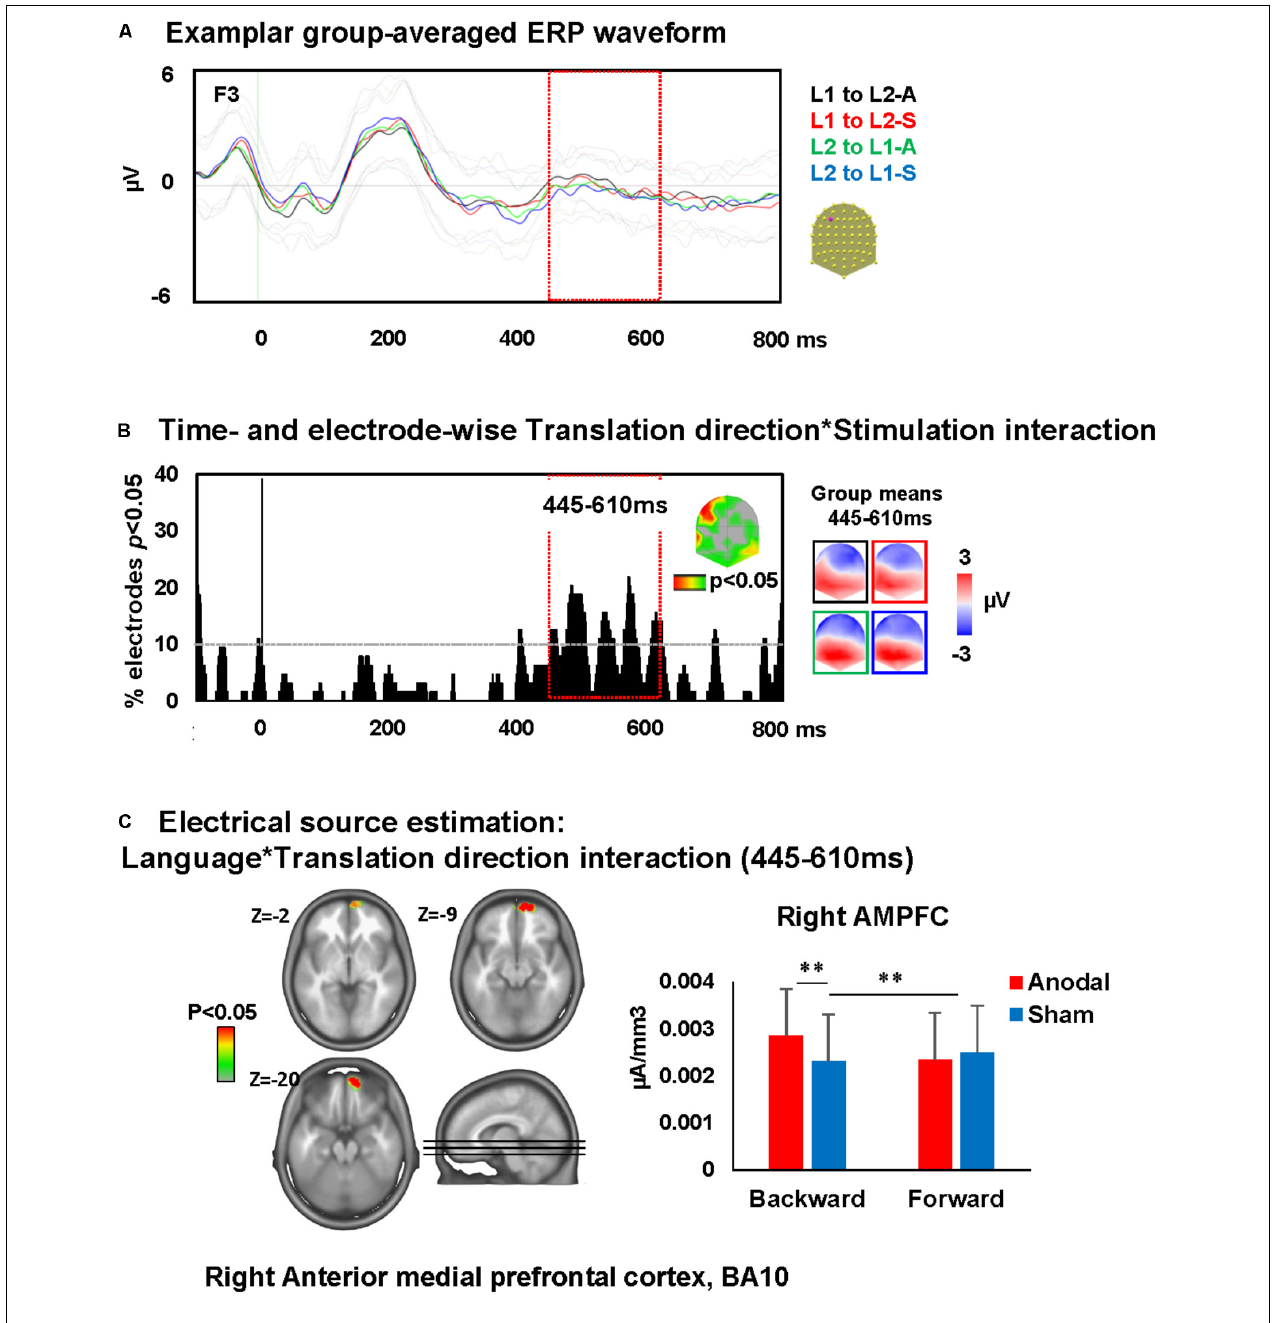
FIGURE 5 | Electrical neuroimaging results: effects of DLPFC tDCS on translation ERP modulations. (A) Superimposed ERP waveforms for the four conditions of interest (L1 to L2-anodal, L1 to L2-sham, L2 to L1-anodal, and L2 to L1-sham) at one exemplary electrode (F3). This figure includes also the standard deviation of the waveforms for each condition (appear in lighter colors). (B) Time and electrode-wise statistical analyses of the ERPs. The graph depicts for each post-stimulus time point the percentage of electrodes showing a significant Language × Stimulation interaction ( p < 0.05). The 445–610 ms period showed an interaction effect ( > 11 ms for > 10% of the electrodes; light orange square). The topographic map represents the electrode sites showing a significant interaction, and on the right the ERP topography for all groups and conditions [same colors as in (A) ]. (C) Statistical analysis of the distributed electrical source estimations over the period of significant Language × Stimulation interaction defined in (C) ( p < 0.05; K E > 14). Z coordinates are indicated on upper left of each MRI slide. ∗∗ p <